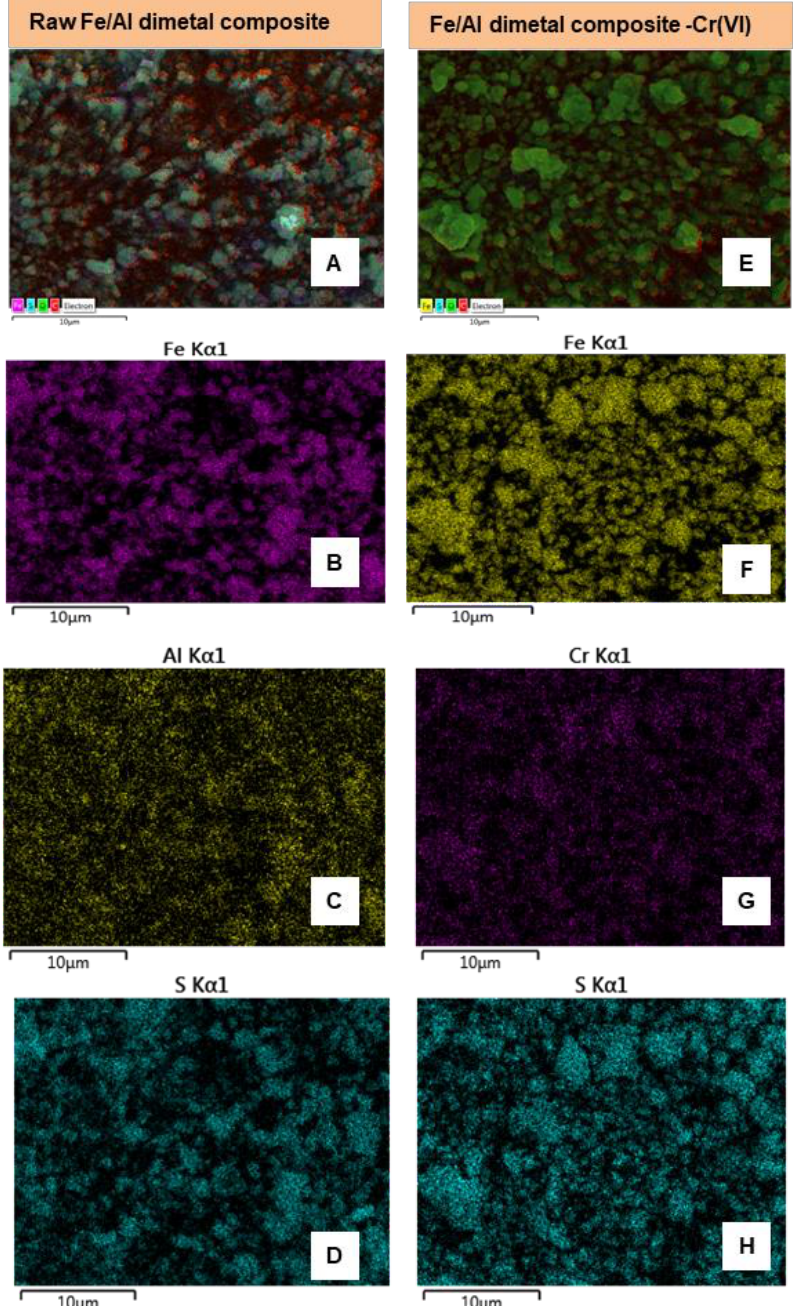
Figure 8. Mapping of elemental composition of the PDFe/Al before adsorption ( A – D ) and after Cr(VI) ( E – H ) adsorption.